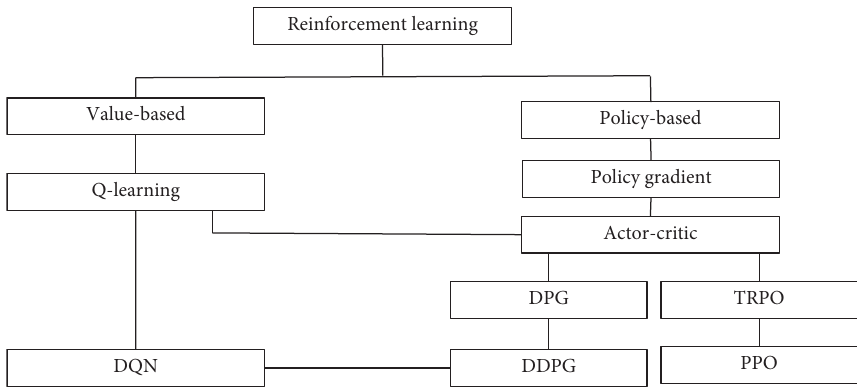
Figure 1: Overview of reinforcement learning